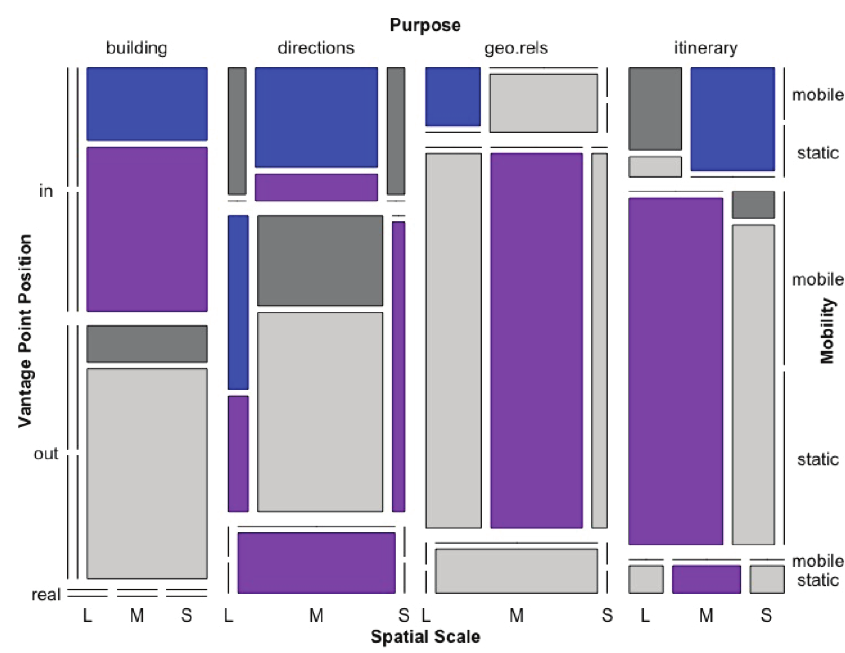
Figure 7: Mosaic plot of scene depiction